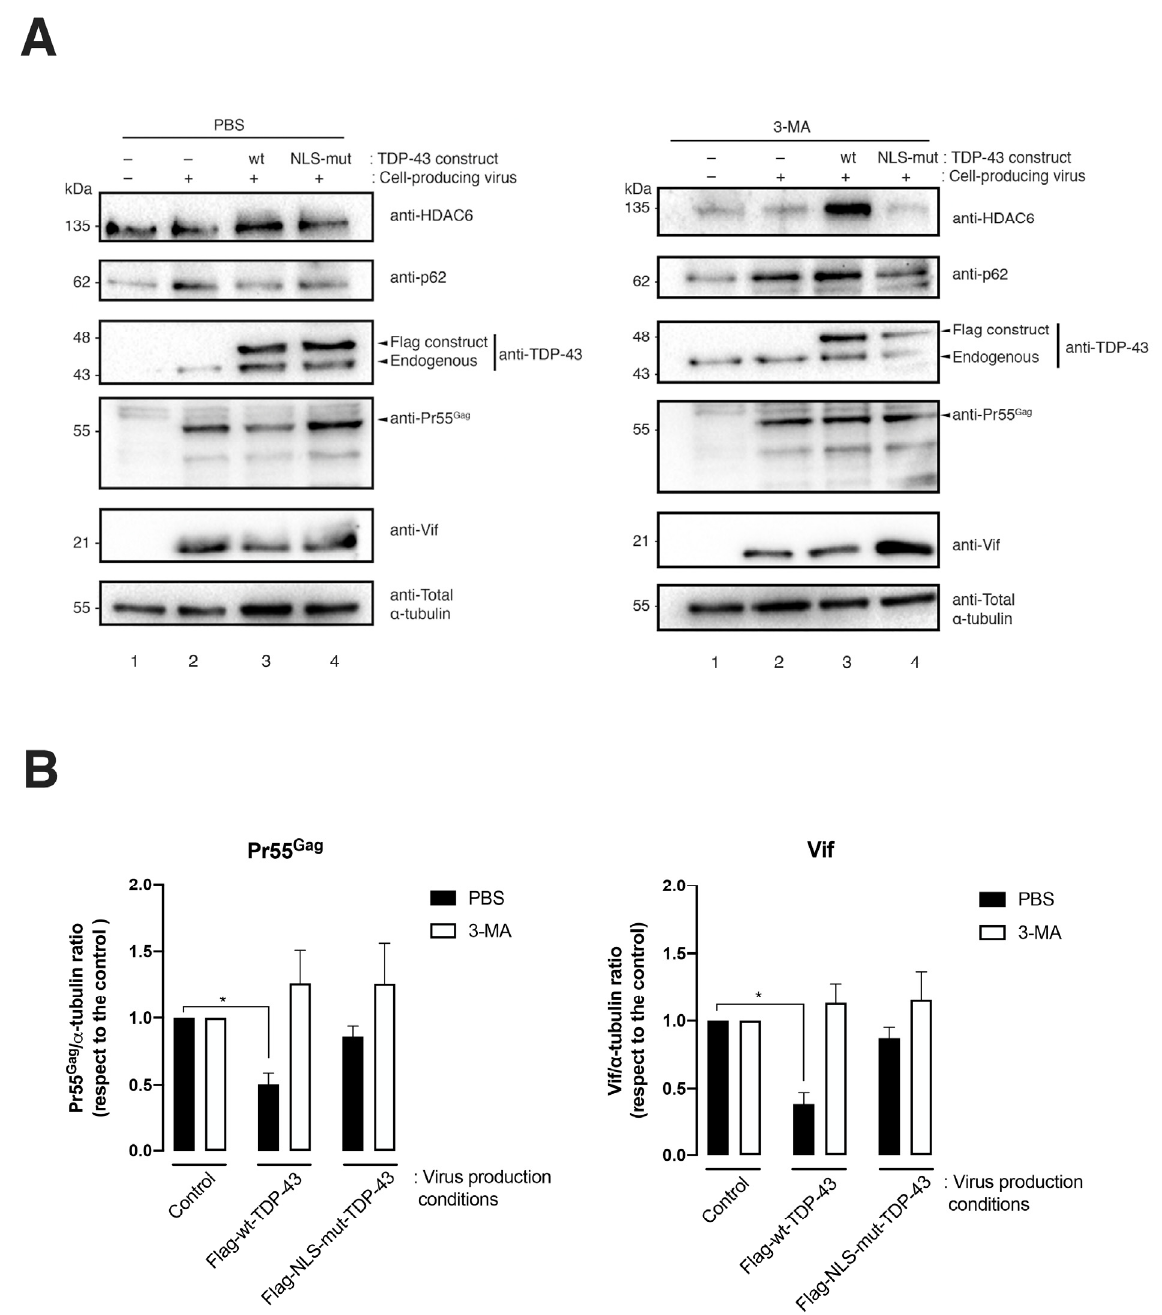
Figure 4. TDP-43 modulates the level of expression of the HIV-1 Pr55 Gag and Vif proteins by promoting HDAC6 protein expression and autophagy degradation. ( A ) The biochemical western blot analysis of Pr55 Gag and Vif degradation together with HDAC6, p62, and acetylated α -tubulin stabilization in virus-producing HEK-293T cells transfected with Flag-wt-TDP-43 and Flag-NLS-mut- TDP-43 and treated with the 3-MA inhibitor (5 mM) or vehicle control (PBS). Total α -tubulin for protein load control is shown under each experimental condition. A representative experiment of three is shown (see replicate data in Figure S4, Supplementary Materials section). ( B ) Histograms show the quantification of western blot bands for the Pr55 Gag /or Vif/ α -tubulin ratio under inhibitor (3-MA) or control (PBS) experimental conditions. Data associated with the quantification of replicates are shown in Figure S4, Supplementary Materials section. Data are represented as the mean ± S.E.M. of three independent experiments. When indicated, * p < 0.05 is the p value for Student’s t test.